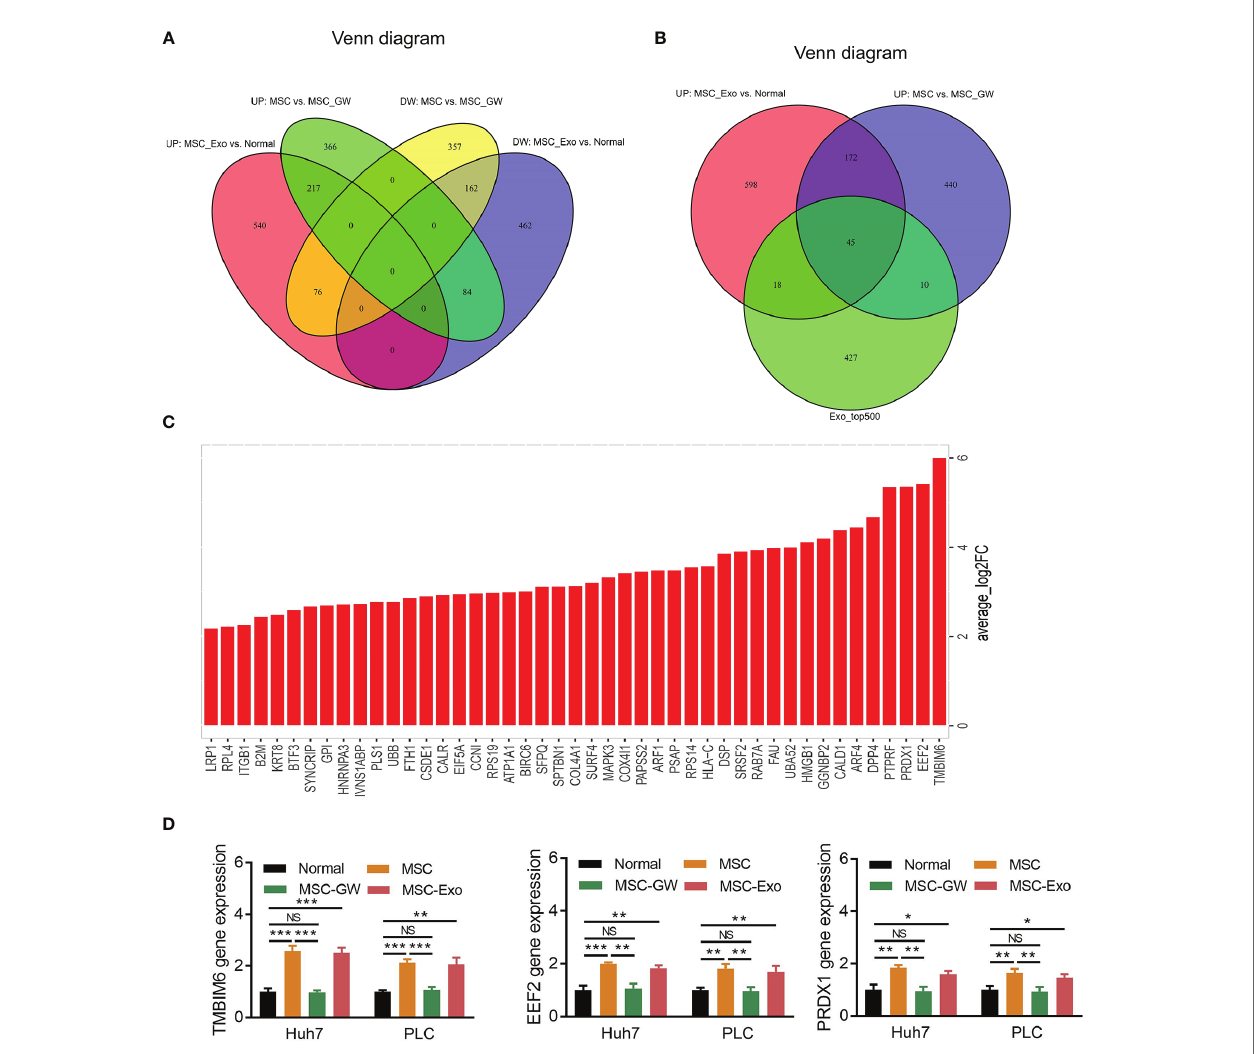
FIGURE 2 | RNA sequencing and RT-qPCR validation. Venn diagram showing upregulated and downregulated DEGs between MSC_Exo versus normal groups and MSC versus MSC_GW group (A) . Venn diagram showing intersection among upregulated DEGs in MSC_Exo versus normal groups, upregulated DEGs in MSC versus MSC_GW group, and top 500 upregulated genes in exosomes of HCC-MSCs (B) . Total 45 genes in the intersection (C) . RT-qPCR validation of TMBIM6, EEF2, and PRDX1 among groups (D) . NS, not signi fi cant; * p < 0.05; ** p < 0.01; *** p < 0.001. DEGs, differentially expressed genes; MSC, mesenchymal stem cell; HCC, hepatocellular